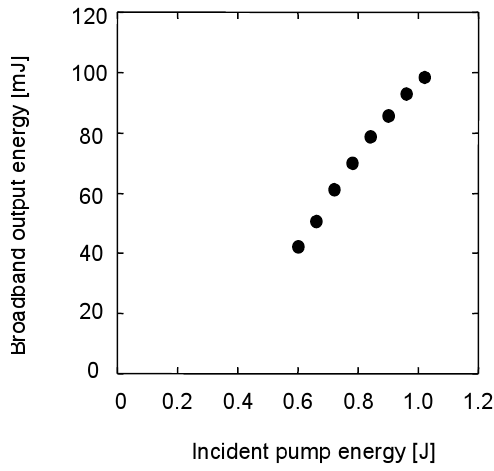
Figure 23. Output energies from the Yb:YAG main amplifier versus the incident pump